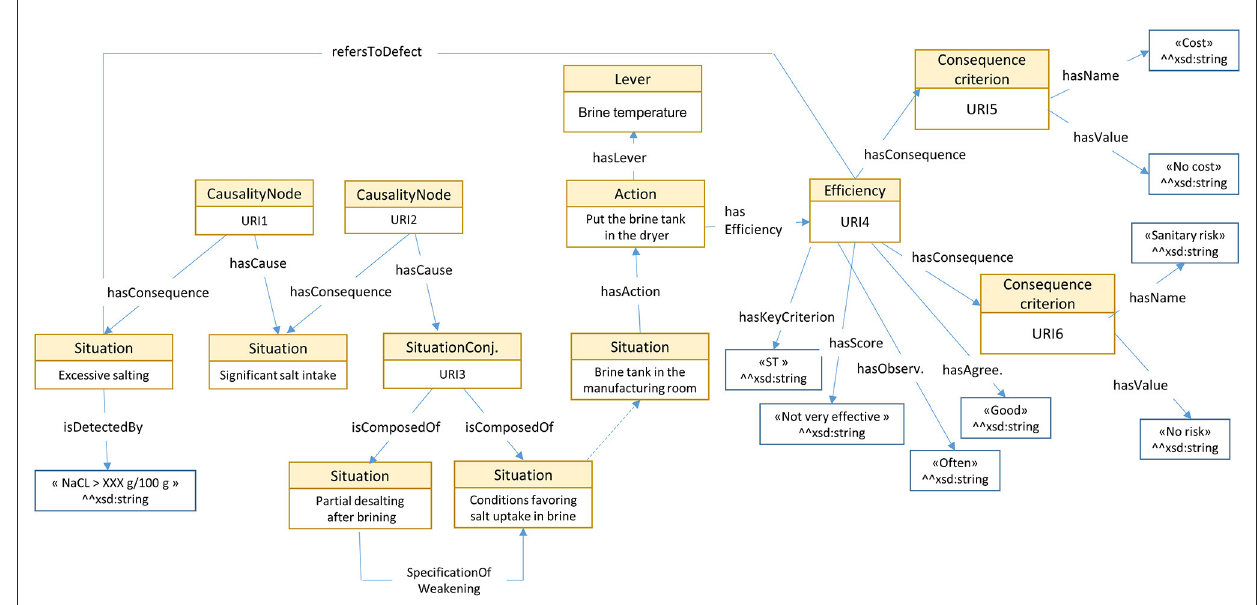
FIGURE5 An excerpt of the MCDSS knowledge base corresponding to the selected branch in Figure 3.